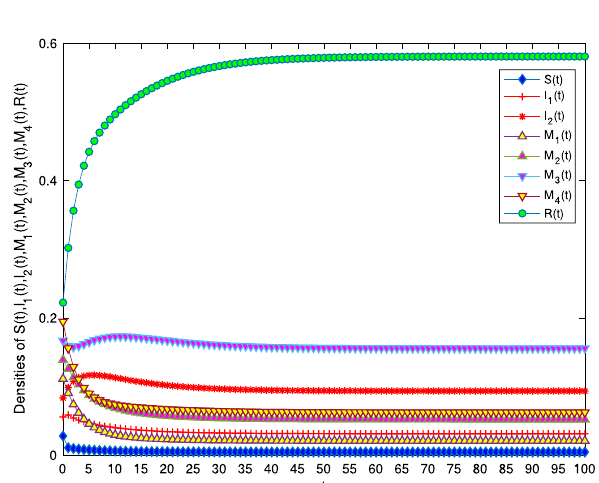
Figure 2. The stability of information-free equilibrium E